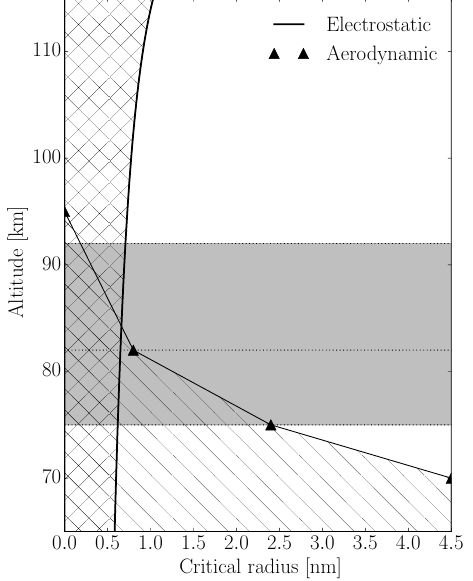
Figure 4. Minimum critical radius due to electrostatic filtering v 2 = eU for vacuum conditions (solid black line) and E kin = m 2 from aerodynamic simulations (black triangles). The aerodynamic critical radius is the minimum size where the detection probabil- ity is larger than zero. The hatchings indicate which particle size cannot be detected. The grey shaded area marks the altitude range of the measured dust layer. The dashed line at 82km indicates the layer peak height.